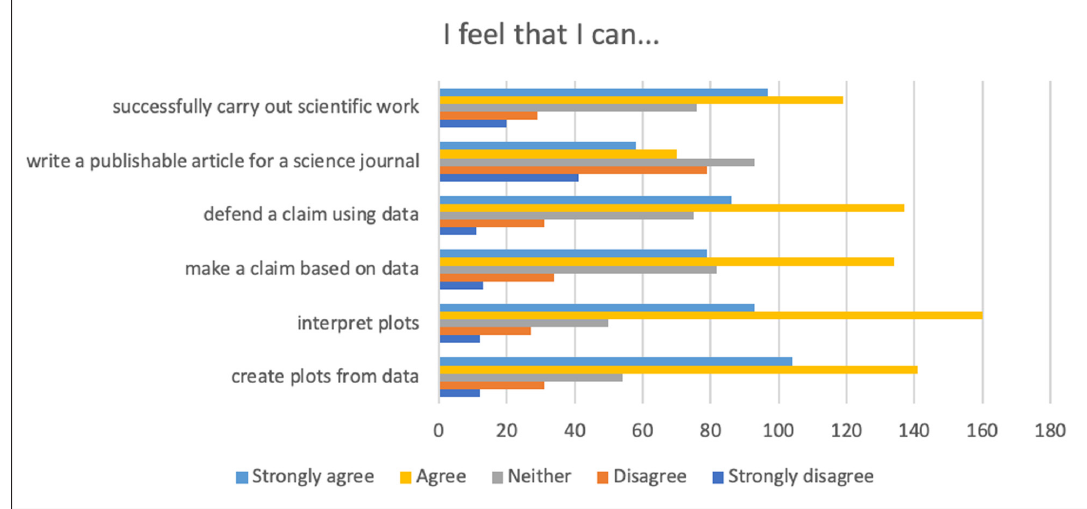
Figure 6: Histogram of responses to questions regarding perceived data analysis and reporting skills (N =